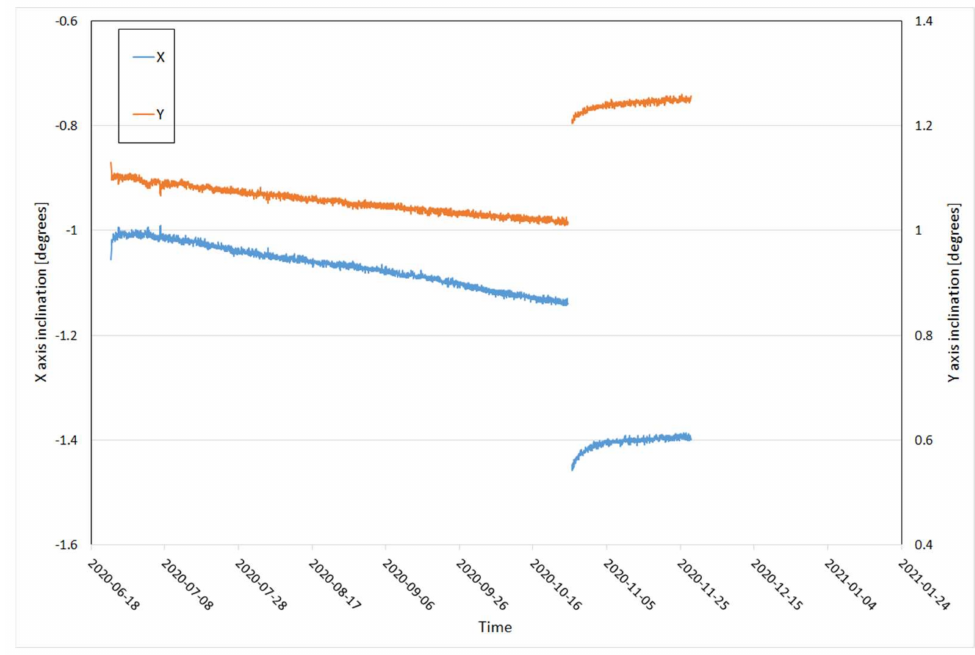
Figure 14. Changes in the slope (X and Y components) recorded by the CNS 227 sensor in the SI-XI/4 panel.